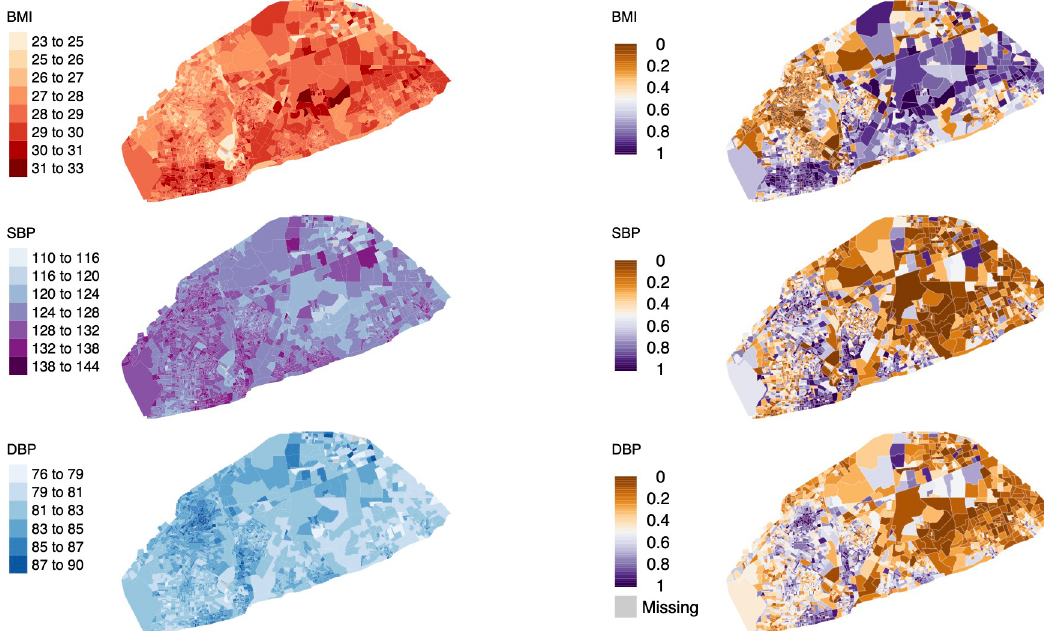
Fig 3. Spatial distribution of BP and BMI among women in Accra. The maps on the left represent the mean EA predicted BMI (kg/m 2 ), SBP (mm Hg), and DBP (mm Hg) for adult women in Accra. The maps on the right represent the posterior probabilities that the mean EA BMI, SBP, and DBP values are greater than the mean values for all EAs. Predictions are missing for 4 EAs (grey) where the sample of women in the census were missing independent variable data. Accra and EA boundaries for the 2010 census are from the Ghana Statistical Service. BMI, body-mass index; BP, blood pressure; DBP, diastolic blood pressure; EA, enumeration area; SBP, systolic blood